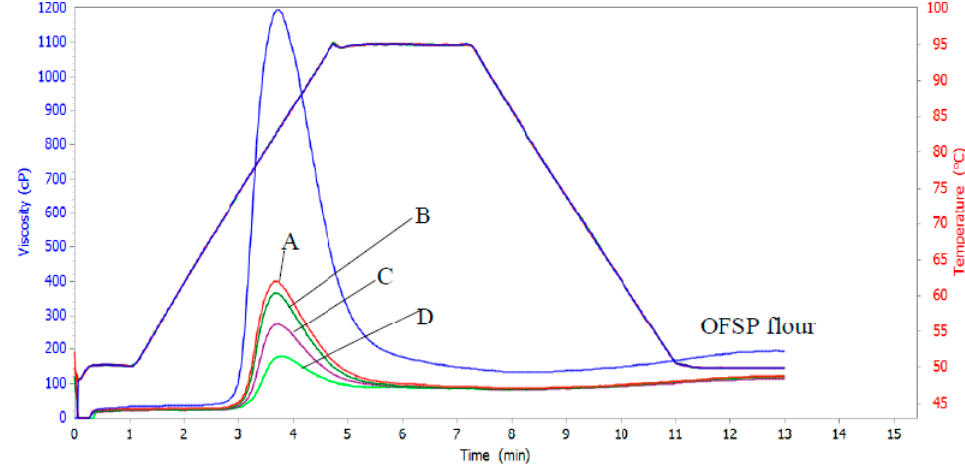
Figure 1. Rapid Visco-Analyzer pasting curves for OFSP and OFSP-based composite flours. Samples A, B, C and D are orange fleshed sweet potato-based composite flours with skimmed milk powder at substitution levels 20%, 25%, 30% and 35% respectively while amaranth leaves powders were 2%, 2.5%, 5% and 10% respectively.